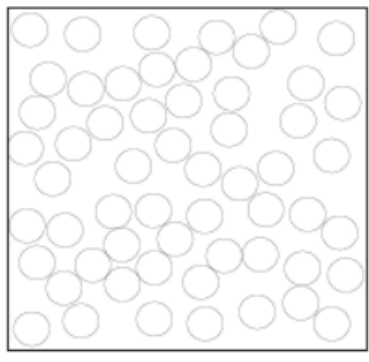
Figure 7. A possible result for the random sequential adsorption (RSA) process.